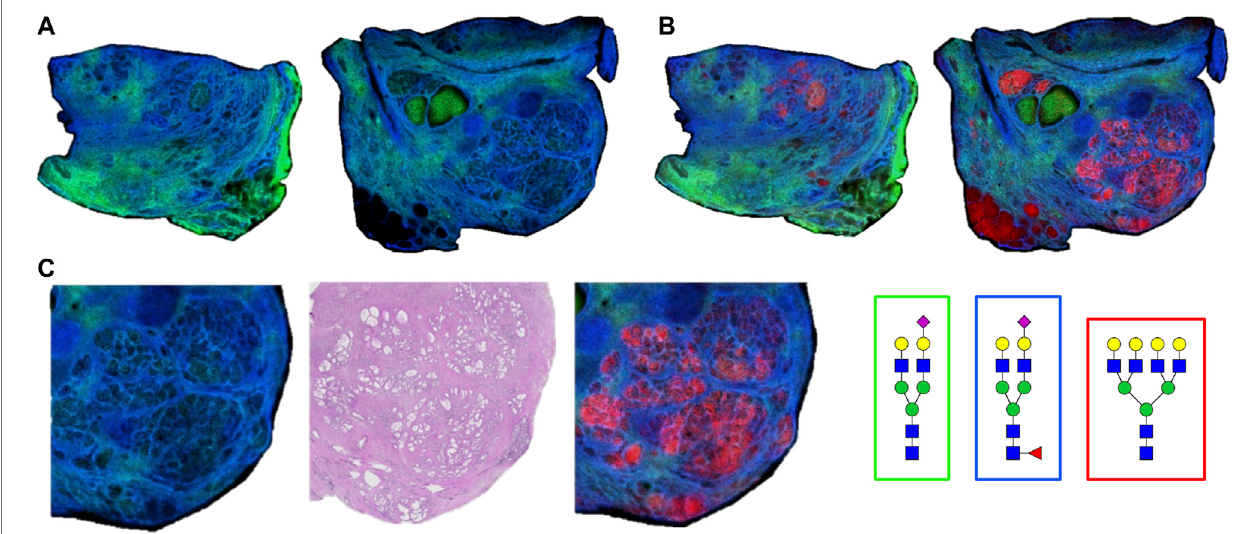
FIGURE 6 | Detection of intralumenal glycans in non-tumor prostate glands. (A) Two distinct stroma-associated glycans, Hex5HexNAc4NeuAc1 in blue and Hex5HexNAc4Fuc1NeuAc1 ingreen, werechosentohighlightthelocationsoftheprostate glands. (B) Anexampleofalumenalglycanisshowninred (Hex7HexNAc6), overlayed with the stroma glycans. (C) Highlighted region of the tumor tissue, bottom right corner, to illustrate the glycan distributions inside the glands. The analogous region in the H&E stained slide is also shown. Structures are bordered with the color that matches their tissue localizations.